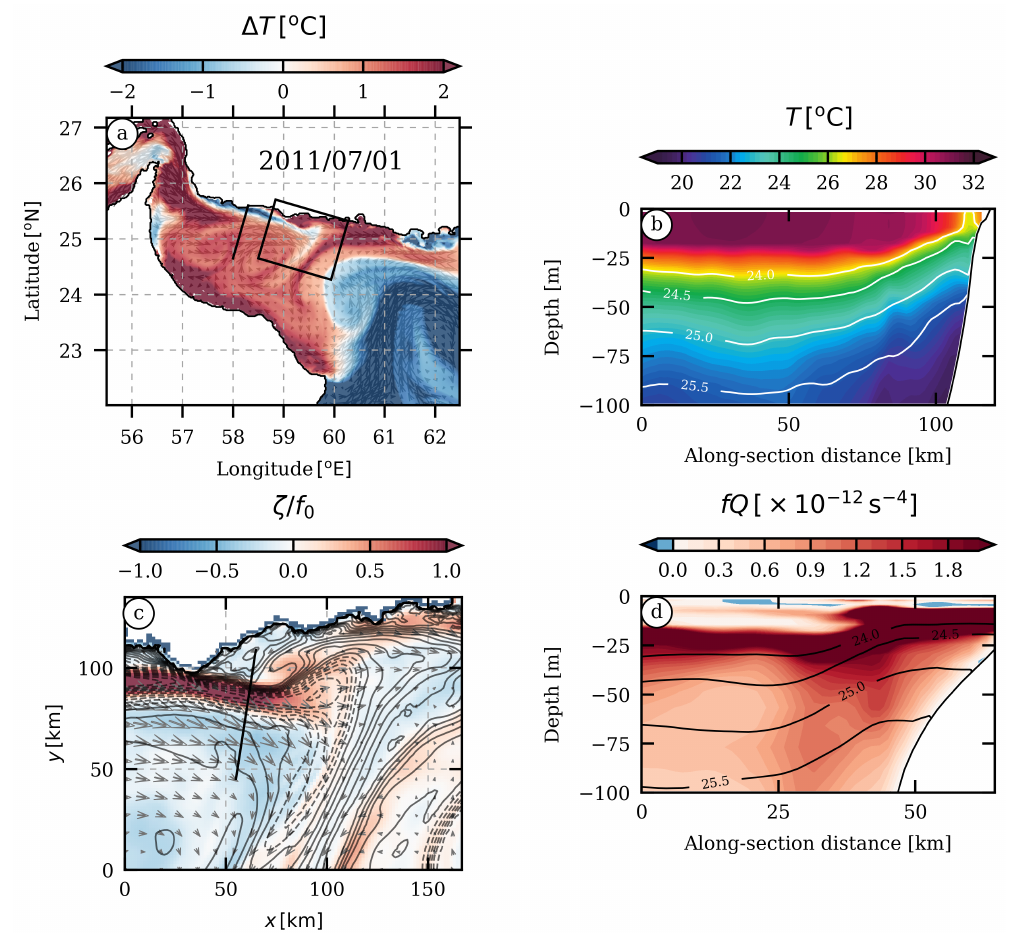
Figure 6. ( a ) Surface temperature anomaly in the Gulf of Oman. Arrows stand for the surface velocity vectors. ( b ) Vertical slice of temperature in the Gulf of Oman. The location of the section is drawn as a black solid line in ( a ). Density contours (kgm − 3 ) are drawn as white solid lines. ( c ) Surface relative vorticity normalized by the areal average of the Coriolis frequency (see black square box in ( a ) for location). Black contours stand for the surface temperature anomaly. Arrows stand for the surface velocity vectors. ( d ) Vertical slice of PV. Density contours (kgm − 3 ) are drawn as black solid